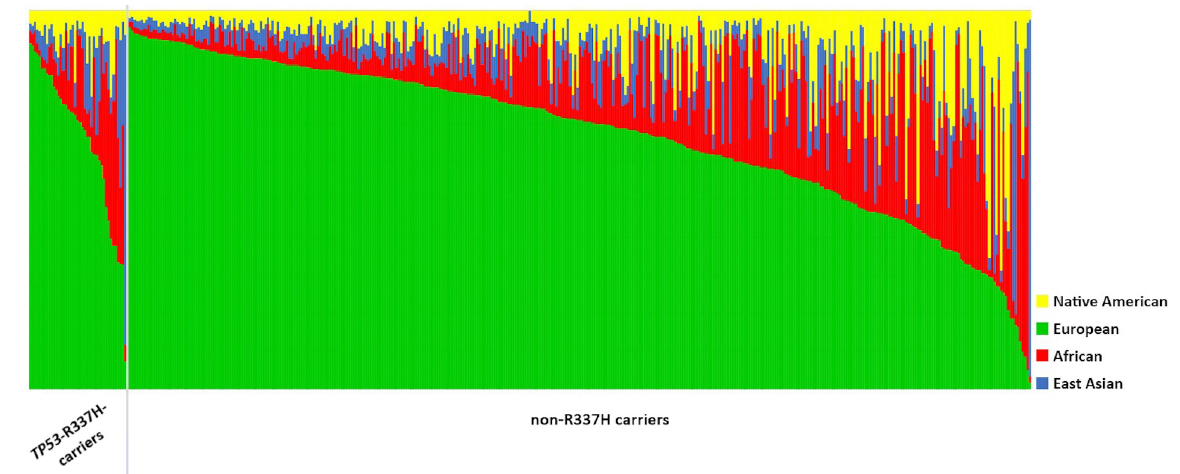
Fig 4. Ancestral profile of all patients analyzed. Left: Patients with the R337H mutation. Right: Patients with the WT phenotype.